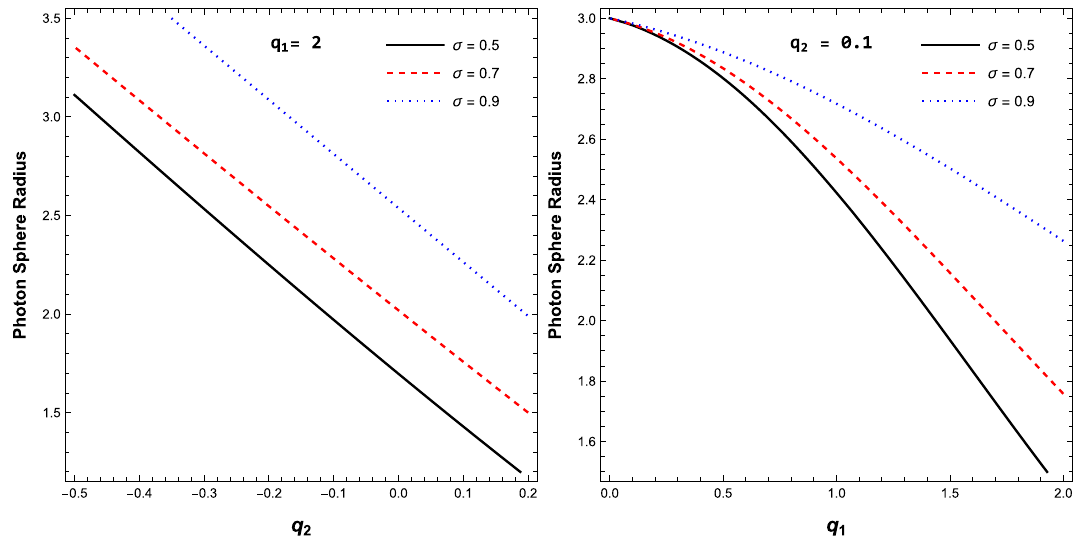
Fig. 7 The dependence of photon sphere radius on q 1 and q 2 for three values of σ . The solid black lines, dashed red lines and dotted green lines correspond to σ = 0 . 5, σ = 0 . 7 and σ = 0 . 9, respectively. In the left plot q 1 is fixed and in the right plot q 2 is fixed